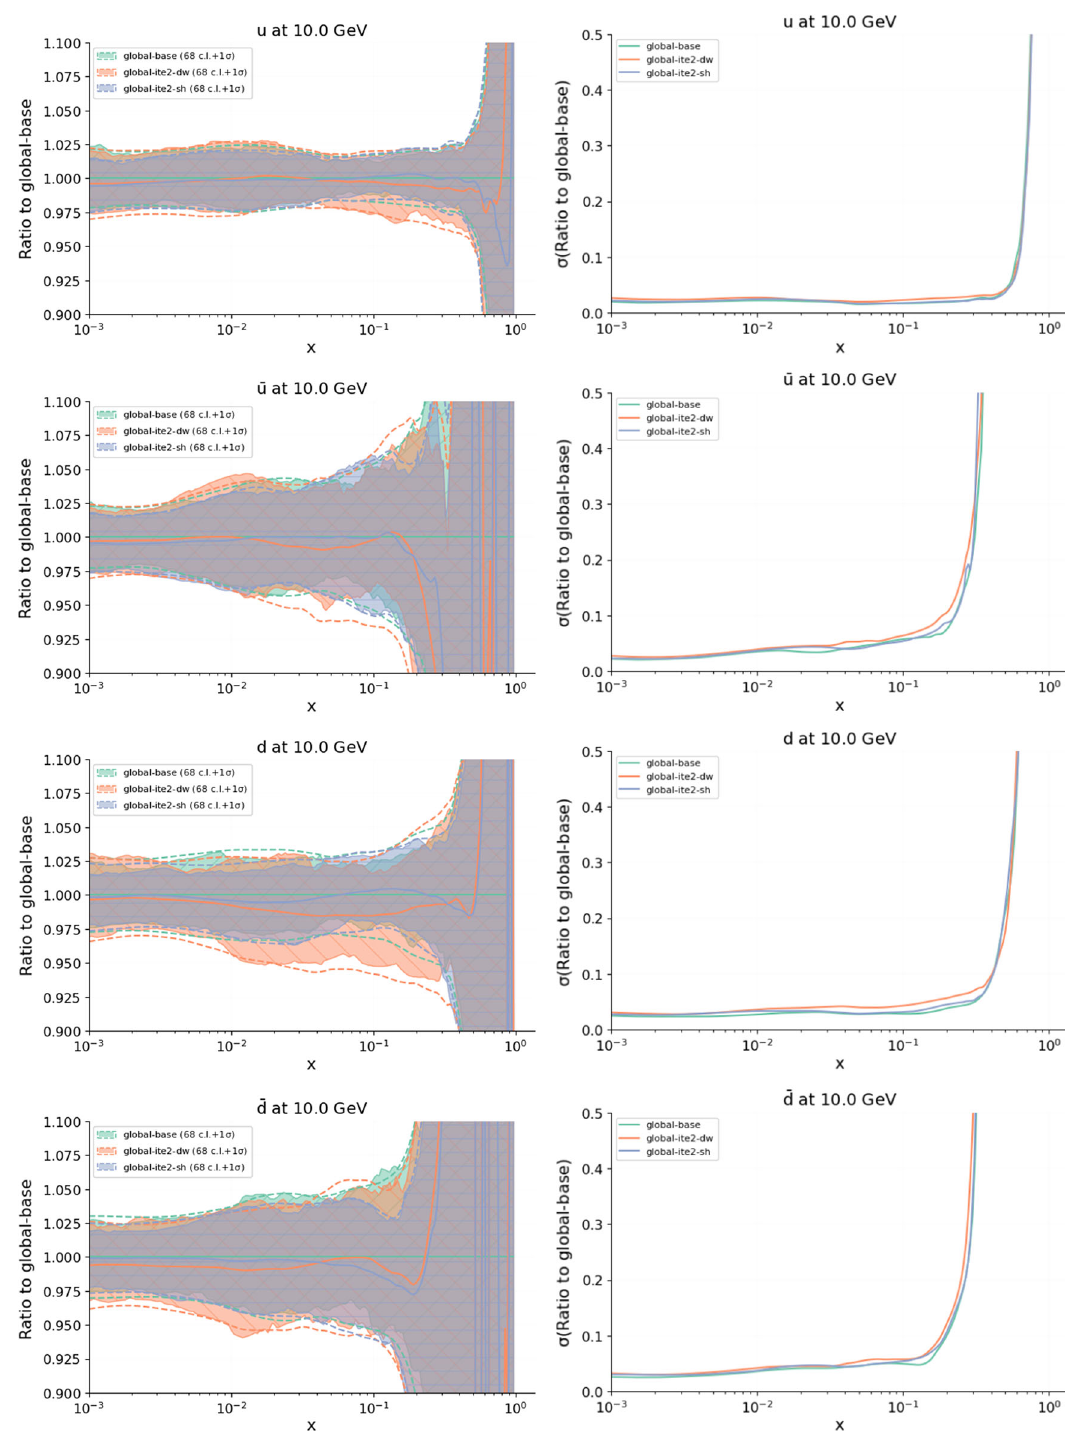
Fig. 8 Comparison between the global-base, global-ite2-dw and global-ite2-sh global fits of proton PDFs. The up, antiup, down and antidown PDFs, normalised to the global-base fit (left) and the cor- responding relative uncertainties (right) are shown at Q = 10 GeV.